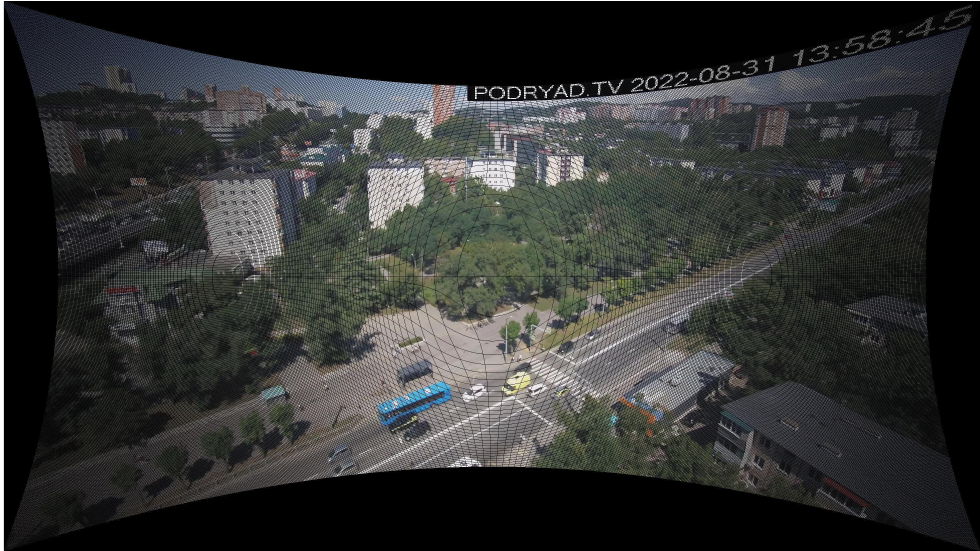
Figure 10. The image Φ after compensation of radial distortion; Example 2, image ˆ Φ = Θ ( Φ ) without postprocessing.